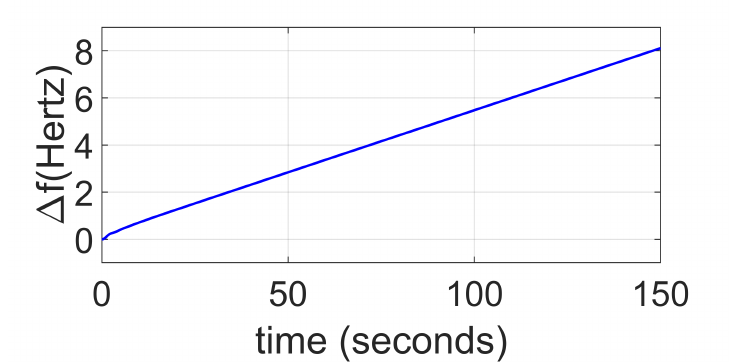
Figure 7. Frequency measurement under ramp attack.